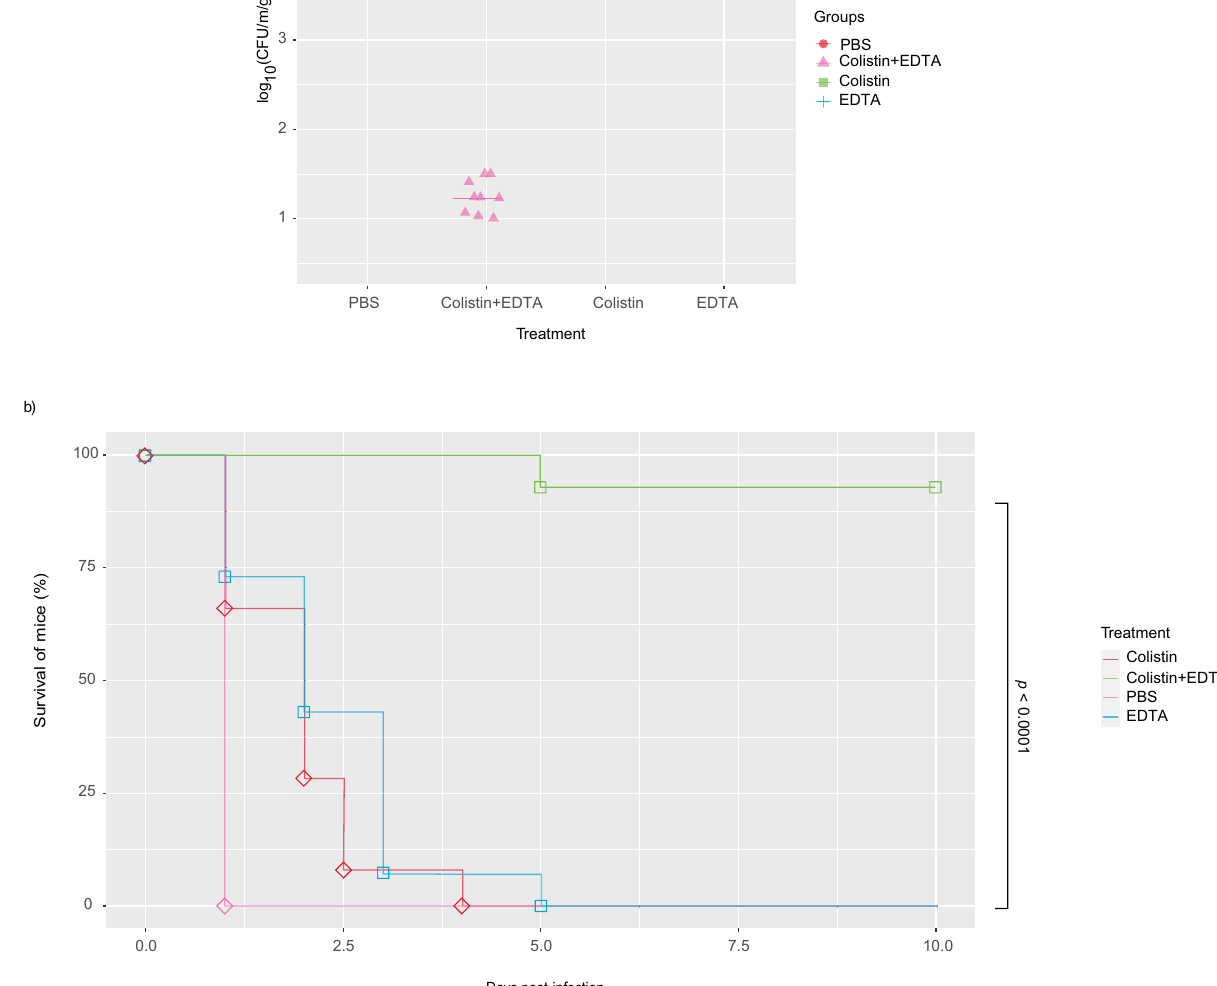
Figure 7. Effects of colistin, EDTA and colistin-EDTA combination therapy on ( a ) bacterial burden in murine peritoneal ColRkp-associated bacteraemia ( b ) survival of treated mice infected with ColRkp-associated